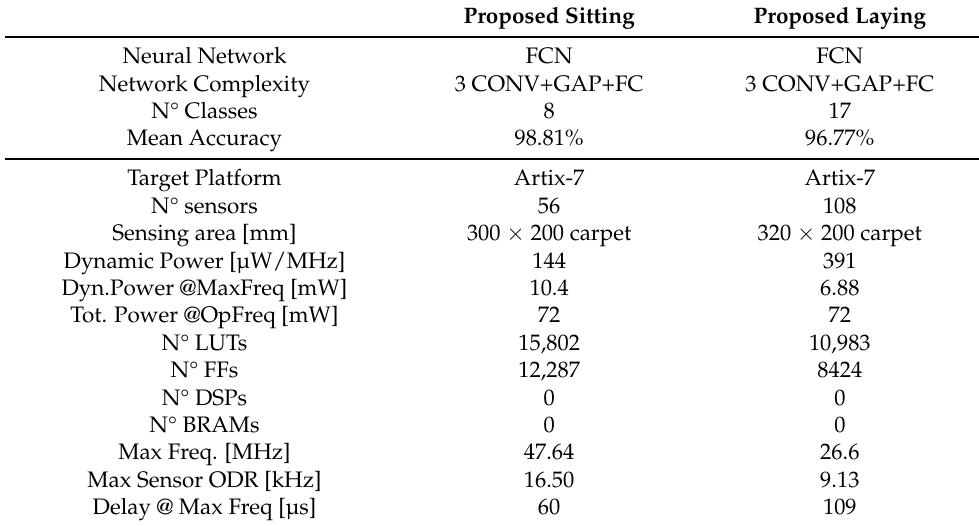
Table 5. FPGA implementation results of the of proposed